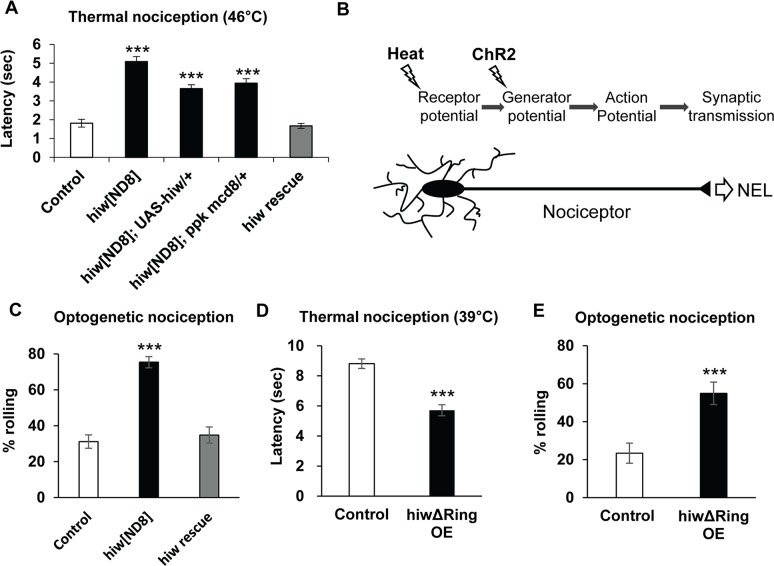
hiw is involved in both desensitizing and sensitizing pathways in nociceptors.(A) Insensitive thermal nociception in hiwND8 mutant and nociceptor-specific rescue of the insensitivity. In comparison to the control w1118 (n = 119, 1.8 ± 0.2), hiwND8 (n = 114, 5.1 ± 0.3), no driver control (hiwND8; UAS-hiw/+, n = 108, 3.7 ± 0.2) and hiwND8 with GAL4 driver (hiwND8; ppk-GAL4 UAS-mCD8::GFP/+, n = 101, 3.9 ± 0.2) all showed significantly delayed nociceptive responses to a 46°C probe, while the rescue genotype (hiwND8; ppk-GAL4 UAS-mCD8::GFP/UAS-hiw, n = 122, 1.7 ± 0.1) had a normal response. *** p < 0.001 (Steel’s test versus control). (B) A schematic of thermal and optogenetic stimulation of a nociceptor. While heat stimuli activate nociceptors via endogenous sensory receptors, ChR2 triggers nociceptor activation independently of sensory reception. (C) The hiw genetic mutant expressing ChR2 in nociceptors was more responsive than the control to optogenetically triggered nociceptor activation, and the nociceptor-specific expression of hiw rescued optogenetic nociception responses to levels similar to control. Control (w1118/Y; ppk-GAL4 UAS-ChR2::YFP/+, n = 154, 31 ± 4%), hiwND8 (hiwND8/Y; ppk-GAL4 UAS-ChR2::YFP/+, n = 191, 75 ± 3%) and hiw rescue (hiwND8/Y; ppk-GAL4 UAS-ChR2::YFP/UAS-hiw, n = 112, 35 ± 5%). *** p < 0.001 (Fisher’s exact test with Bonferroni correction). (D) hiwΔRing expression (hiwΔRing OE) in nociceptors resulted in thermal hypersensitivity. hiwΔRing OE animals (ppk-GAL4 x UAS-hiwΔRing, n = 90, 5.7 ± 0.4) showed a significantly shortened latency to respond to a 39°C thermal probe compared to controls (ppk-GAL4 x w1118, n = 104, 8.8 ± 0.3). *** p < 0.001 (Mann-Whitney’s U-test). (E) hiwΔRing expression in nociceptors induced hypersensitivity to optogenetic nociceptor stimulation. hiwΔRing-expressing animals (ppk-GAL4 UAS-ChR2::YFP x UAS-hiwΔRing, n = 71, 55 ± 6%) exhibited increased responsiveness to optogenetic stimulation of nociceptors compared to control animals (ppk-GAL4 UAS-ChR2::YFP x w1118, n = 64, 23 ± 5%). *** p < 0.001 (Fisher’s exact test). All error bars represent standard error.